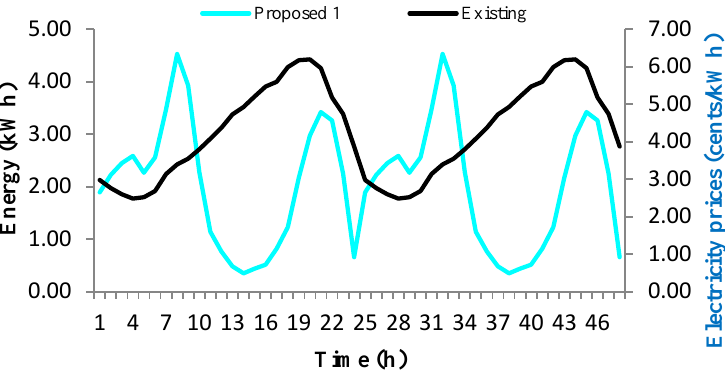
Figure 11. Comparison of energy and cost saving between the proposed 1 and existing scenarios over 48 h time period.